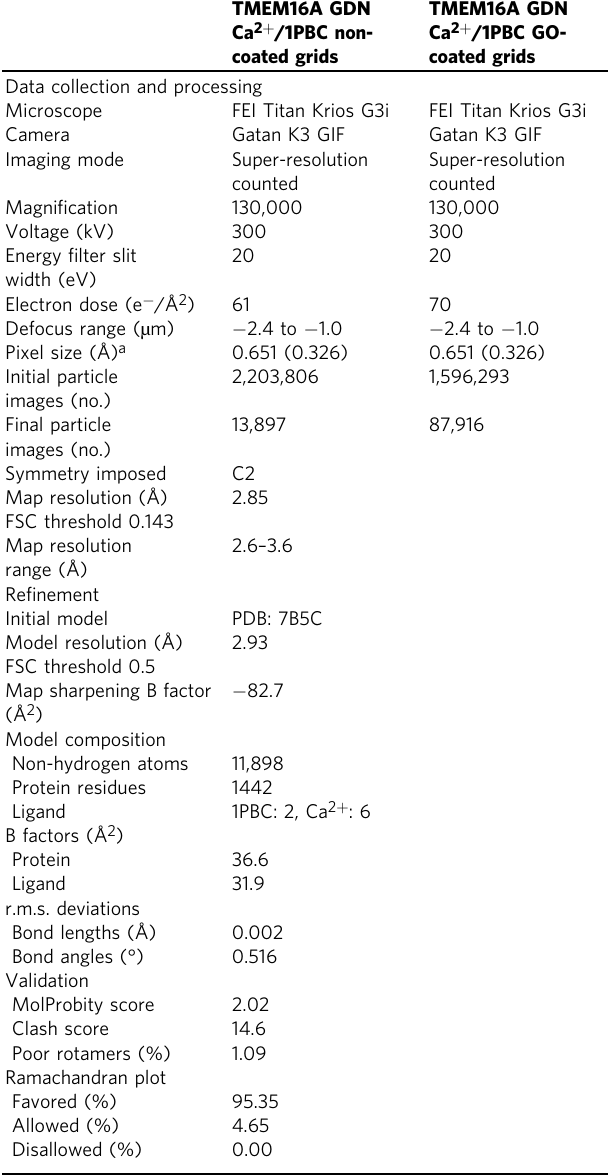
Table 1 Cryo-EM data collection, processing, re fi nement, and validation